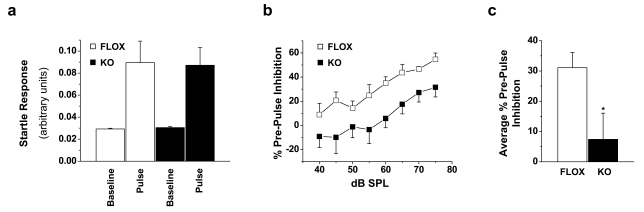
Neuronal rictor deletion results in sensorimotor gating deficits as assayed by PPI.(A) No difference in startle reflex elicited by a 94 decibel (dB) sound pressure level (SPL) noise was observed between rictor KO and littermate FLOX control mice. (B) The percentage of PPI was reduced significantly across the entire dB range in rictor KO mice. (C) The average PPI across the entire dB range reveals a significant deficit in PPI in rictor KO mice; n = 6–7 animals. *p<0.05 Student's t test.